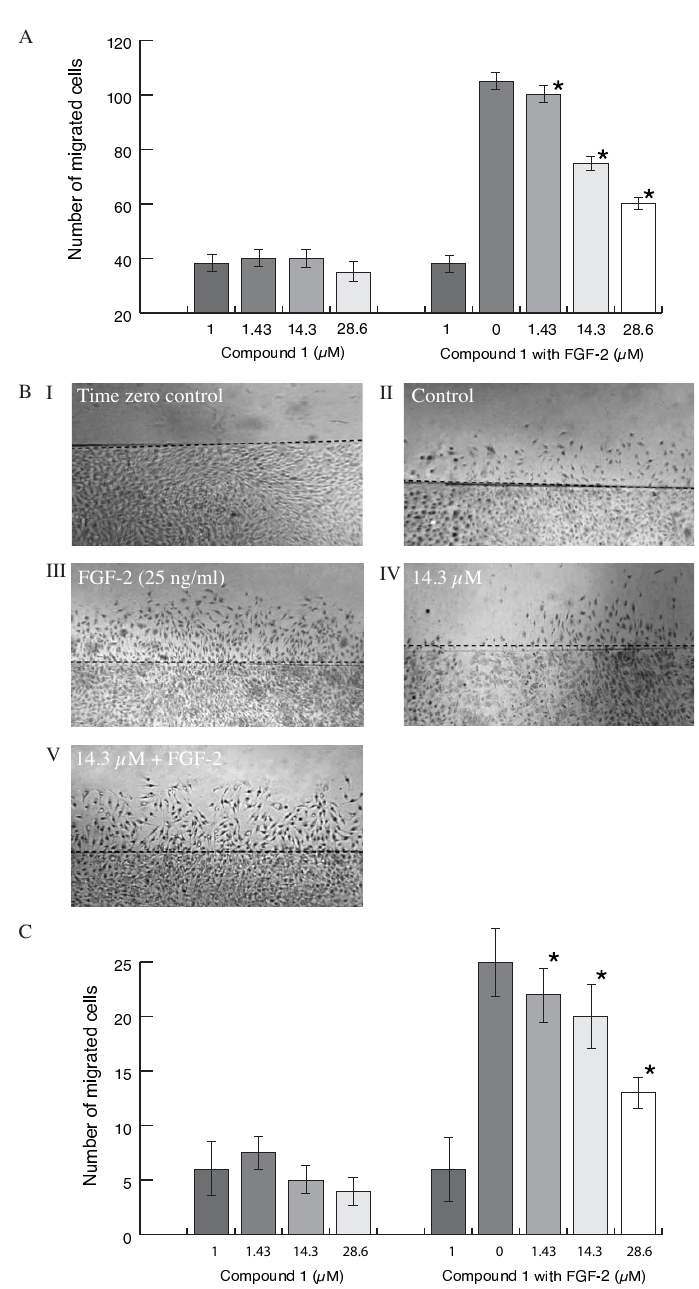
Figure 4 Effect of stilbene glycosides on FGF-2 induced BAEC migration . (A) A cell monolayer was wounded as described below and recovery was assessed in the presence of increasing concentration of the test compounds. Results are shown for compound 1 . Values significantly different from FGF-2 alone (p < 0.05) are shown by *. (B) Representative photomicrographs (original magnification × 20) show the effect of compound 1 on BAEC migration. DMSO was used as the control. (C) The effect compound 1 on FGF-2-induced cell migration in a three dimensional Boyden chamber assay. Cells were added to the upper chamber and the compound at a range of concentrations, with and without FGF-2 (25 ng/ml) added to the lower cham- ber (see below for method). The total number of migrated cells to the lower chamber was counted as described below. Col- umn 1, control. The results are the mean of three experiments and values significantly different from FGF-2 alone (p < 0.05) are shown by